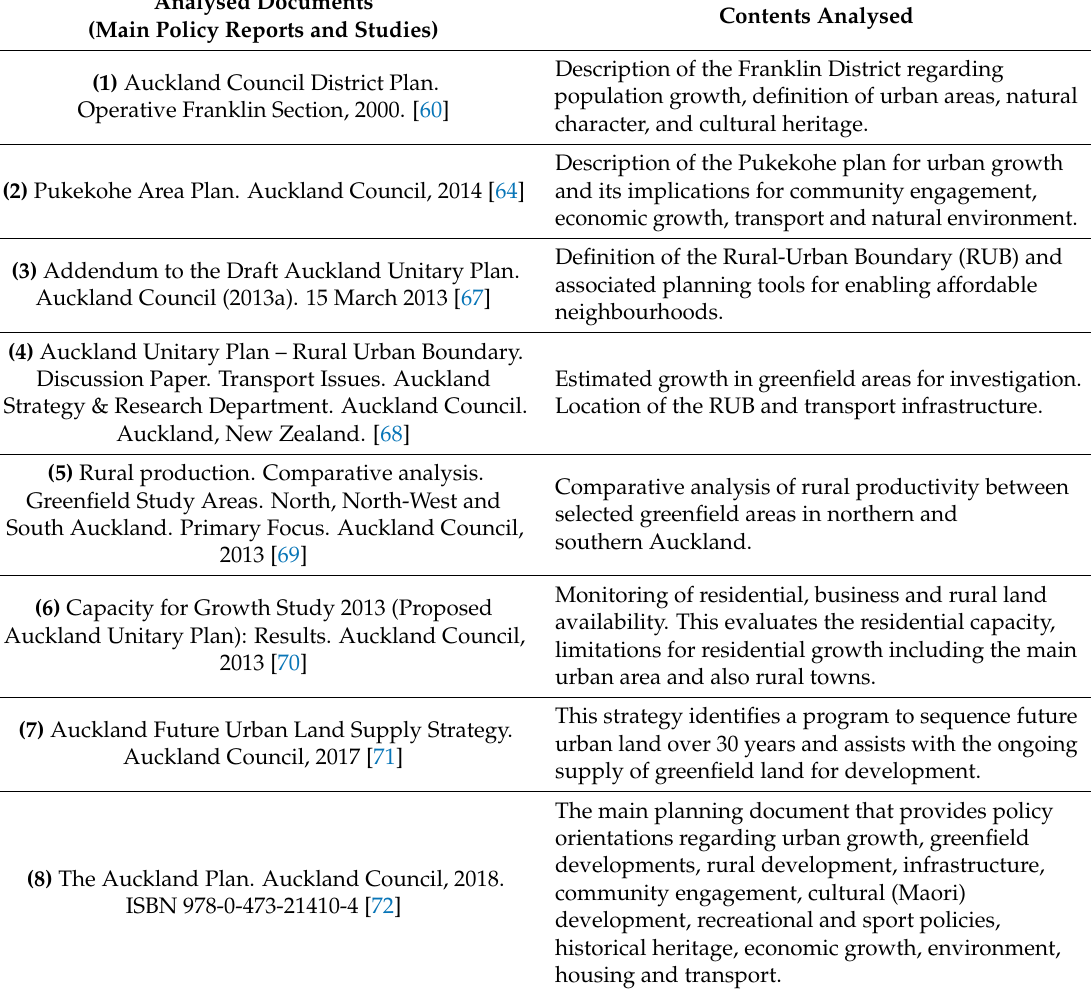
Table 1. Selected documents and main content